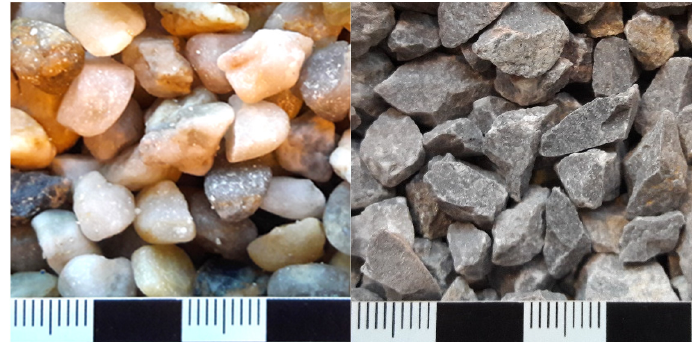
Figure 3. Quartzite (left, 7.1/8 mm) and limestone (right, 5.6/8 mm).